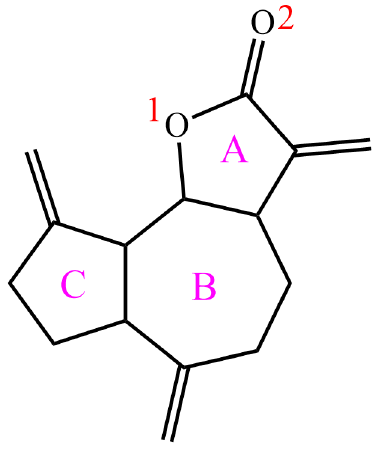
Figure 1. Chemical structure of